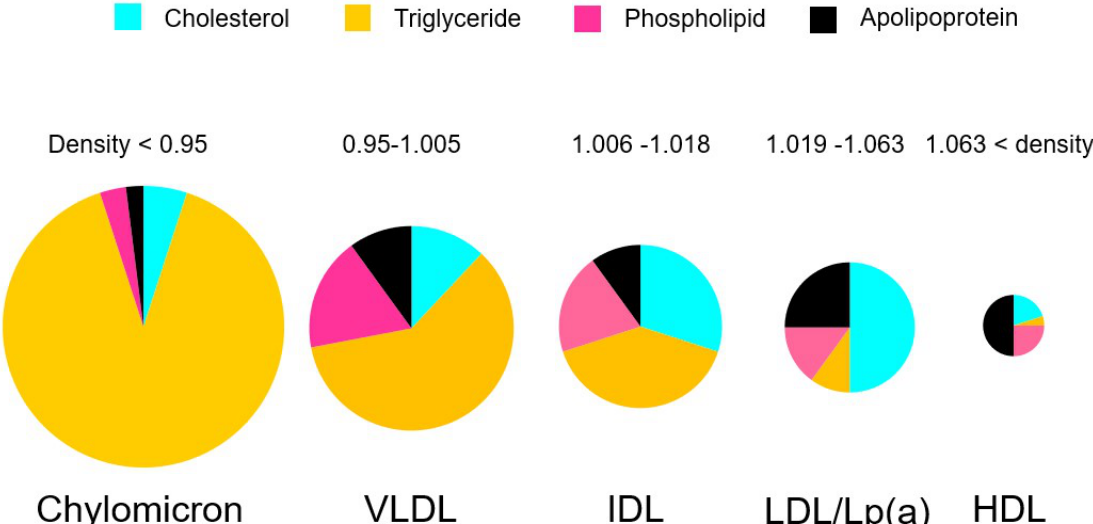
Figure 1. Lipid content of each lipoprotein. Light blue indicates cholesterol. Orange indicates triglycerides. Pink indicates phospholipid. Black indicates apolipoprotein. Chylomicron, very low-density lipoprotein (VLDL), and intermediate-density lipoprotein (IDL) are recognized as triglyceride-rich lipoproteins, and LDL is regarded as cholesterol